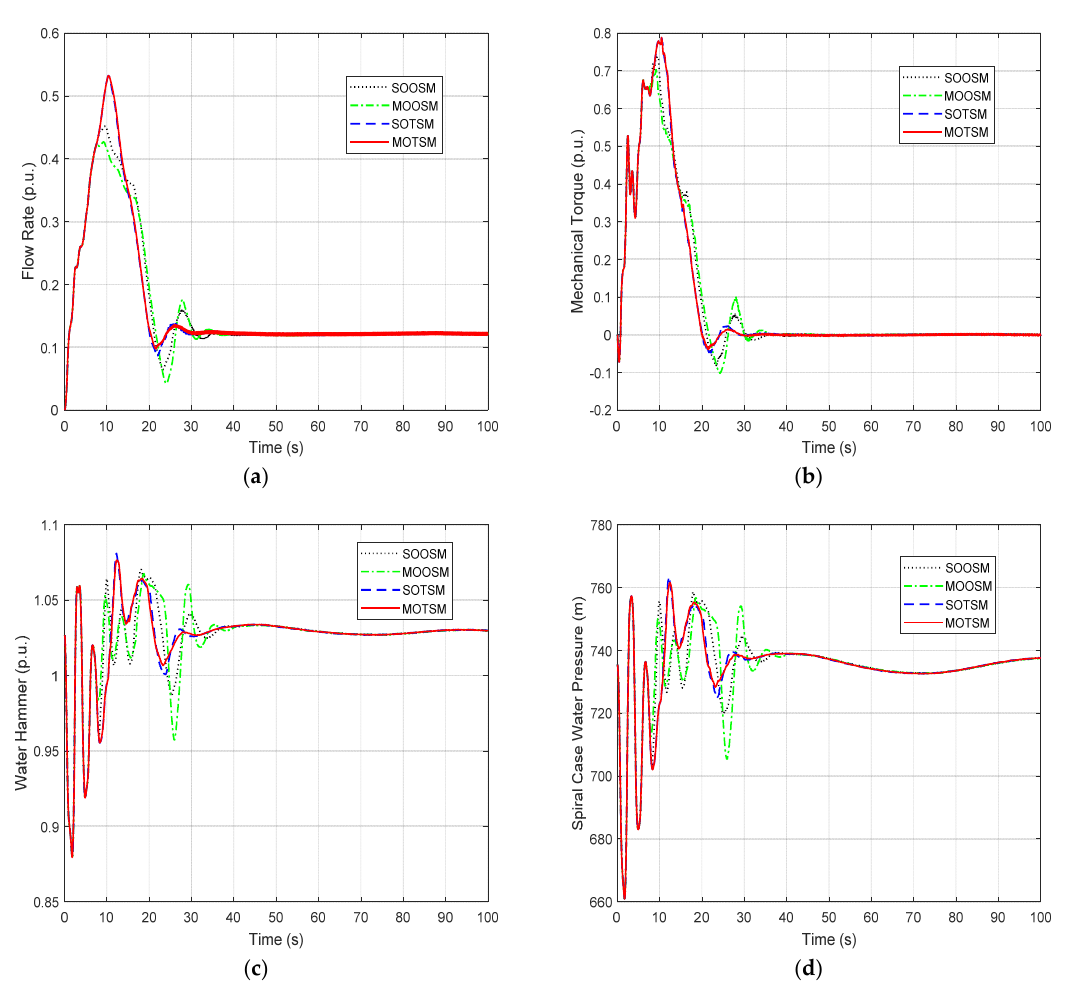
Figure 11. Transient processes of the PSU with different solutions: ( a ) Flow rate of optimal solutions; ( b ) Mechanical torque of optimal solutions; ( c ) Water hammer of optimal solutions; ( d ) Spiral case water pressure of optimal solutions.